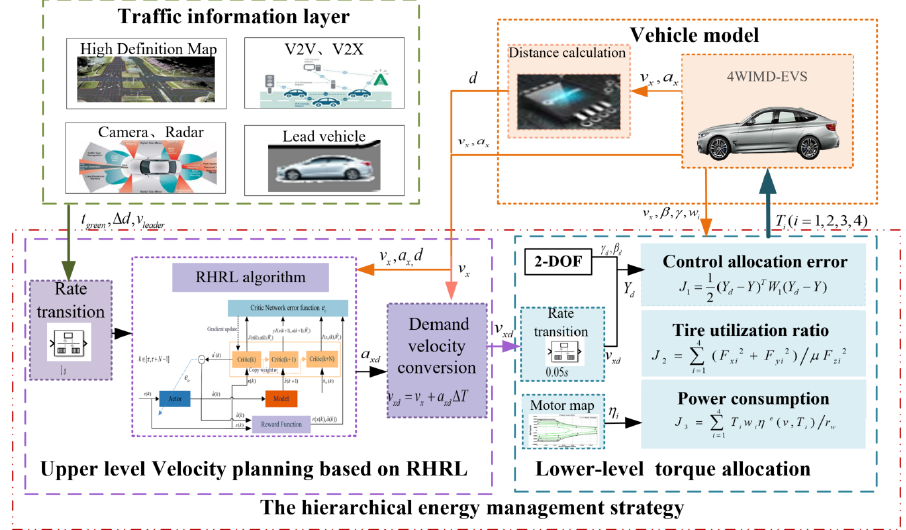
Figure 1. The hierarchical energy management control strategy of EVs in